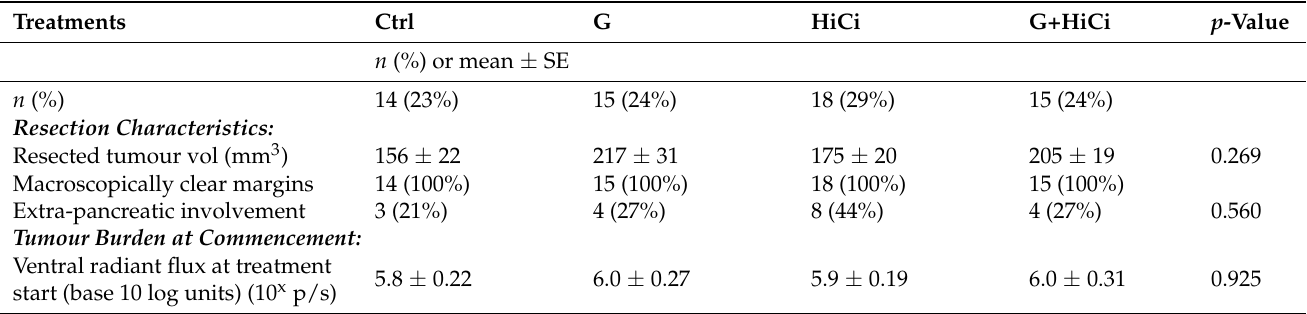
Table 1. Characteristics of the mice at the commencement of